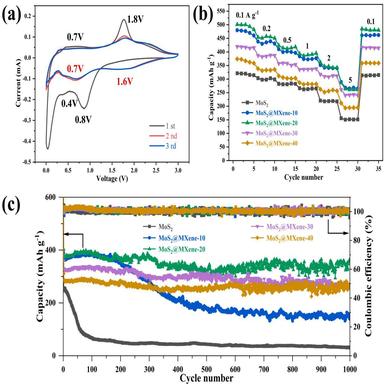
(a) CV curves of MoS2@MXene-20 composite at 0.1 mV s − 1 , (b) Rate performance of MoS2 and MoS2@MXene composites, (c) Cyclic performance of MoS2 and MoS2@MXene composites.